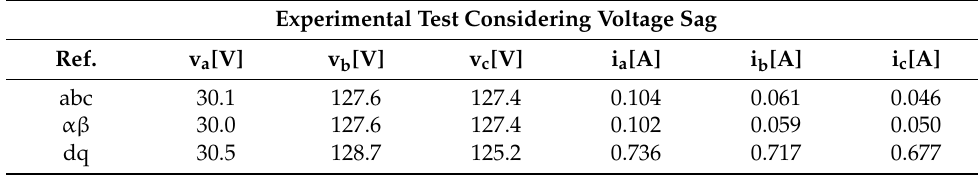
Table 4. Output current disturbance due asymmetrical voltage sag—rms values.